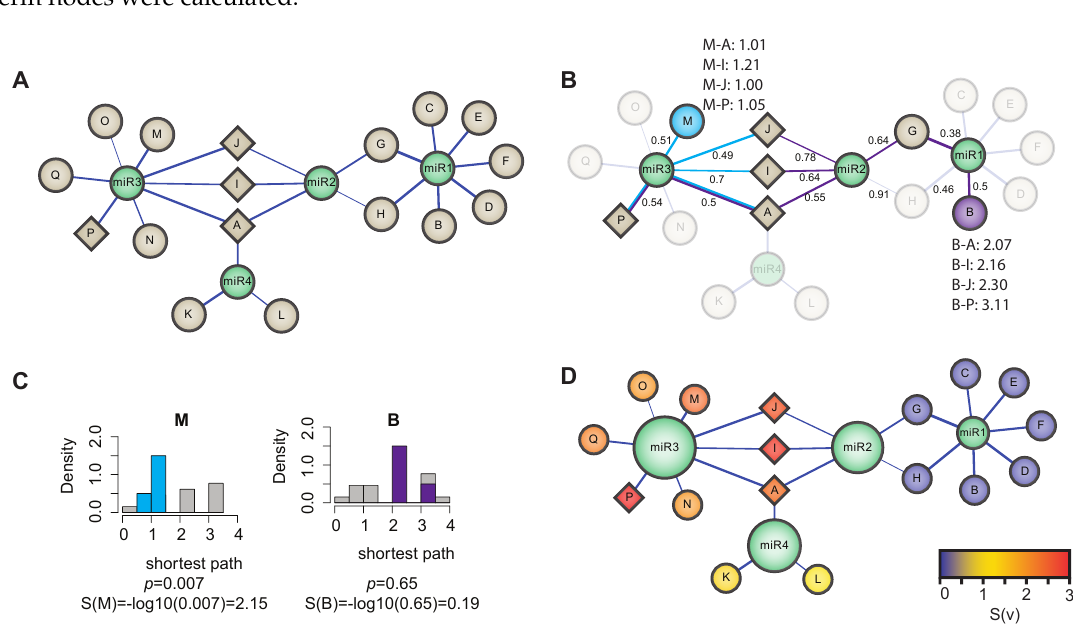
Figure 3. Node scoring strategy of local enrichment analysis. ( A ) Example of a network in which the nodes are represented by miRNAs (green) and genes (grey) and the edges are represented by the mi-/mRNA interactions. The network is given as input for the functional annotation step. We assume that four genes are assigned to a certain functional group—A, I, J, P (diamond shape); ( B ) The transformed network after computing the shortest path distances between these four nodes and the two nodes M (blue) and B (purple). The edge labels denote the weights after the transformation. The edge weight indicates the strength of the mi-/mRNA negative regulation; ( C ) The distribution of shortest paths from node M to the nodes A, I, J and P is significantly shifted to lower values. No shift can be observed for node B. The p -values determined by left-tailed Wilcoxon rank-sum test are converted to the node scores; ( D ) Network visualization after annotating functional groups. The node scores are indicated by the color. The size of the miRNA nodes corresponds to the miR